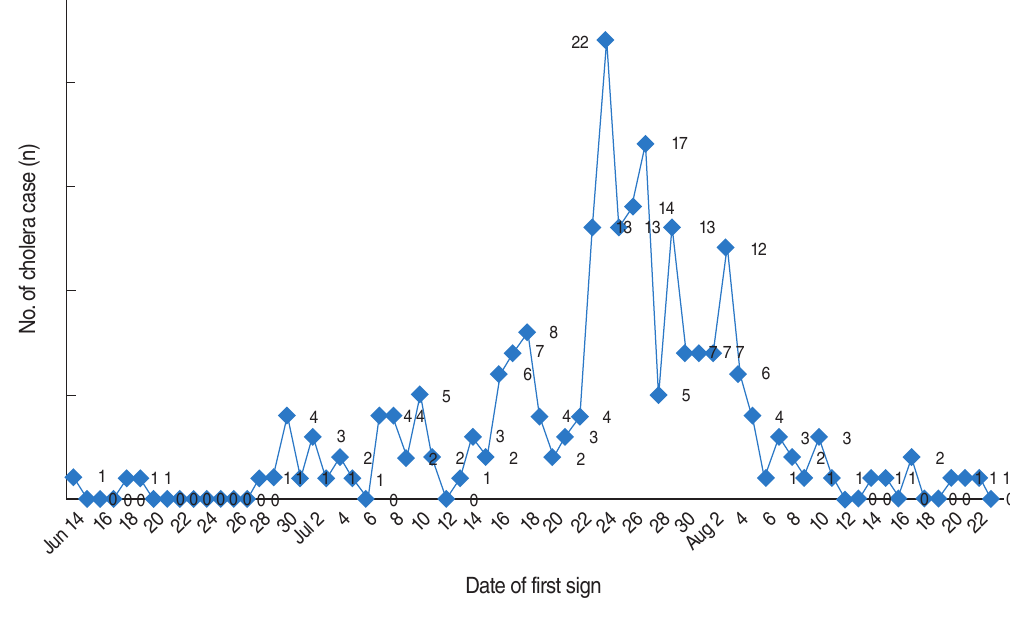
Figure 1. Epidemic curve of cholera outbreak in Alborz Province,